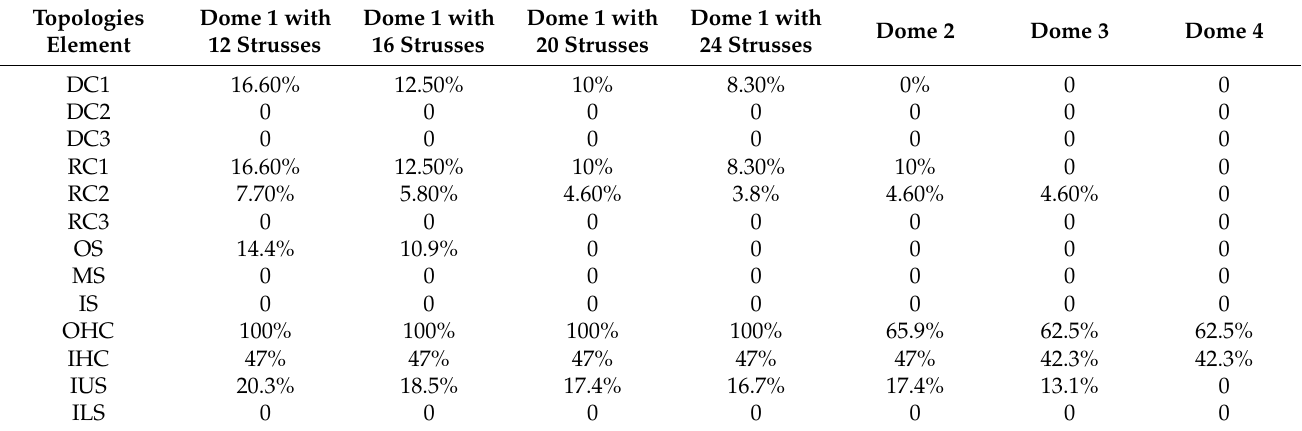
Table 3. Collapse areas formed because of the removal of different structural elements under different topological relationships.